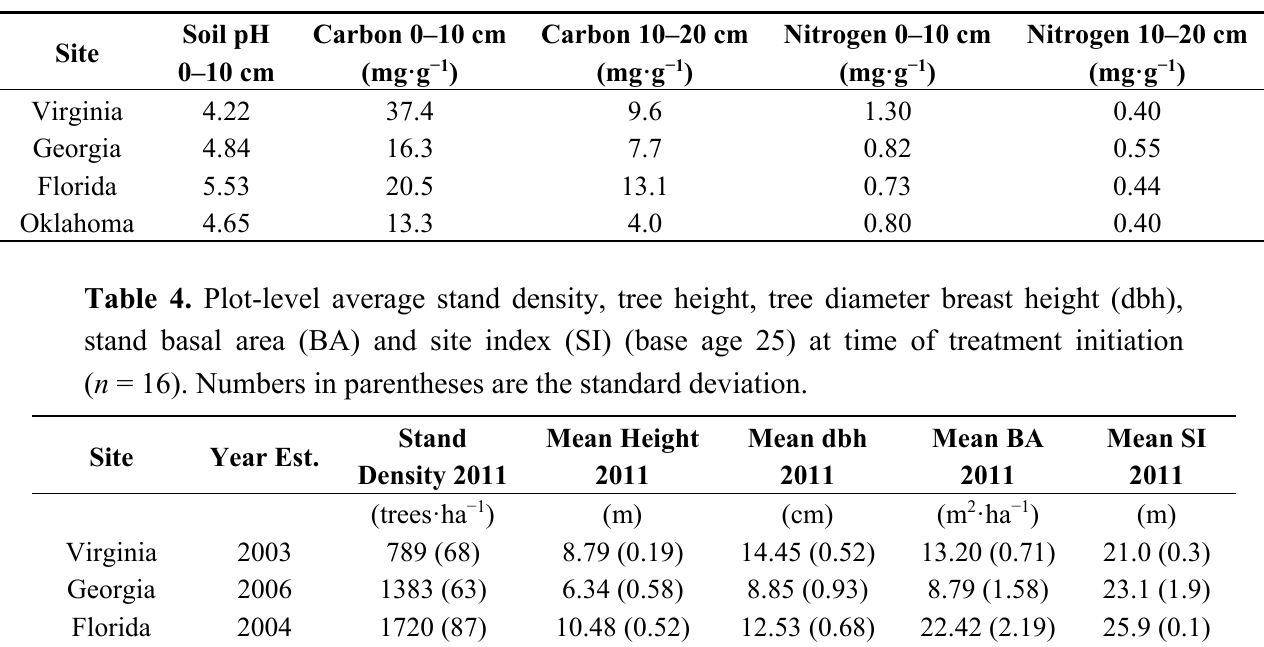
Table 3. Soil pH and carbon and nitrogen concentrations for the four throughfall reduction x fertilization study sites established in non-thinned, mid rotation loblolly pine plantations.